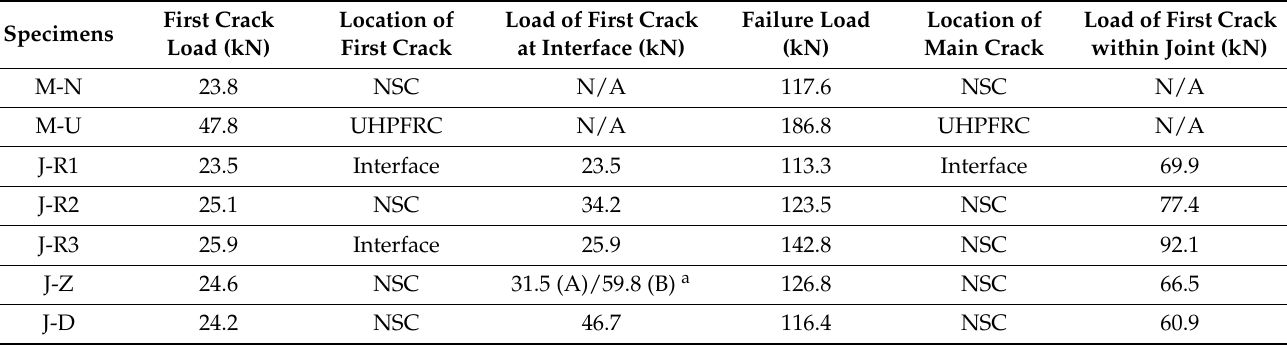
Figure 7. Cracking patterns and failure modes: ( a ) M-N; ( b ) M-U; ( c ) J-R1; ( d ) J-R2; ( e ) J-R3; ( f ) J-Z; ( g ) J-D. Table 4. Crack details and corresponding loads (kN) of the specimens.